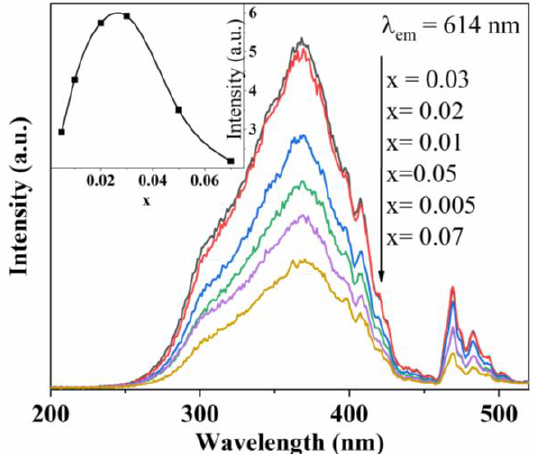
Figure 6. Sm 3+ doping concentration-dependent excitation spectra of Lu 2(1 − x) Sm 2x MoWO 9 . Inset shows the x value-dependent CTB intensities.